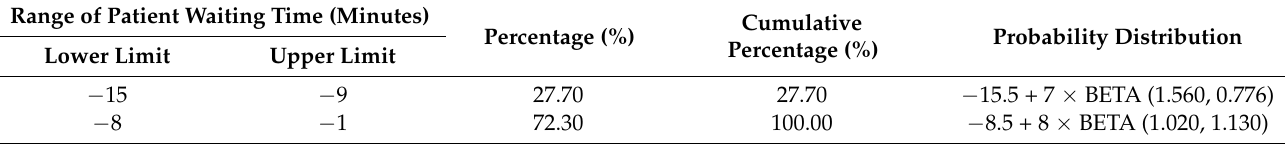
Table 3. F3 distribution for early